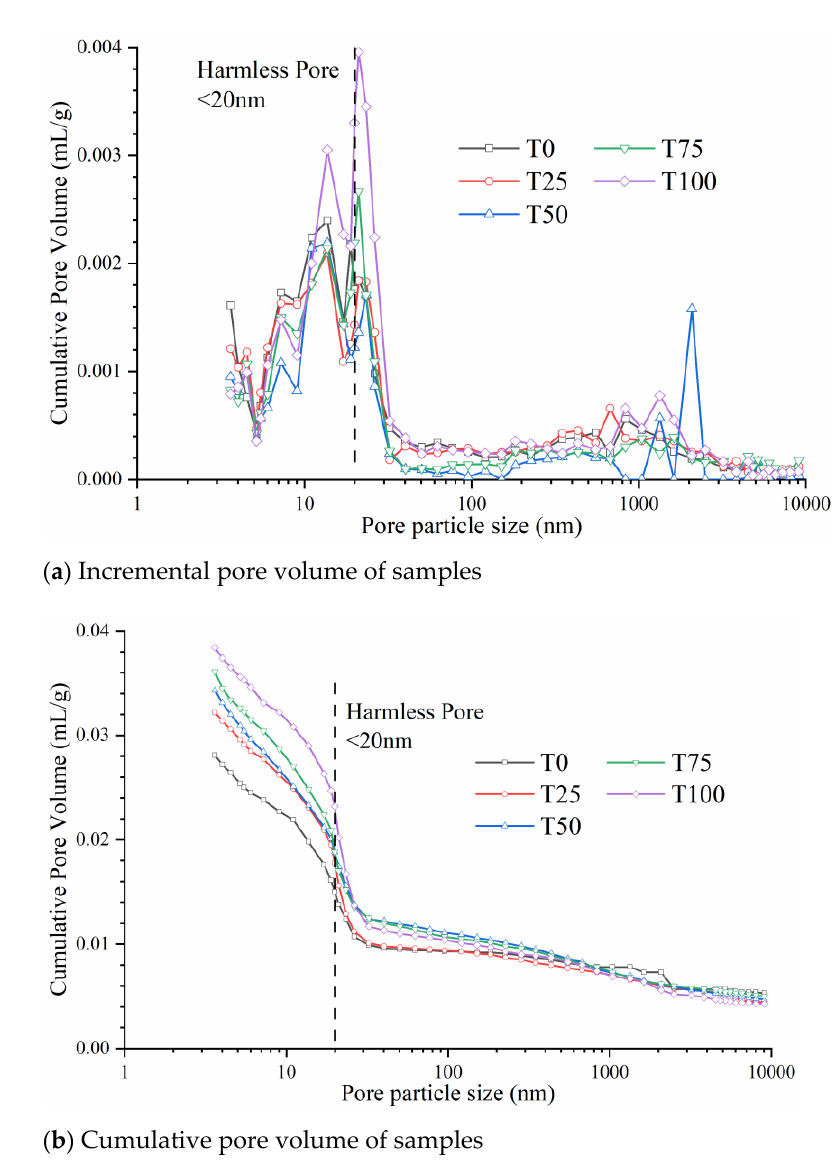
Figure 9. Pore structure analysis of hardened UHPC.